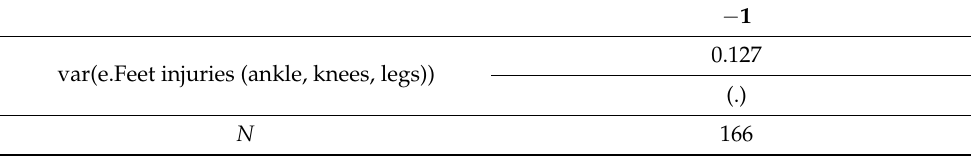
Table 6. Cont. var(e.Feet injuries (ankle, knees, legs)) N